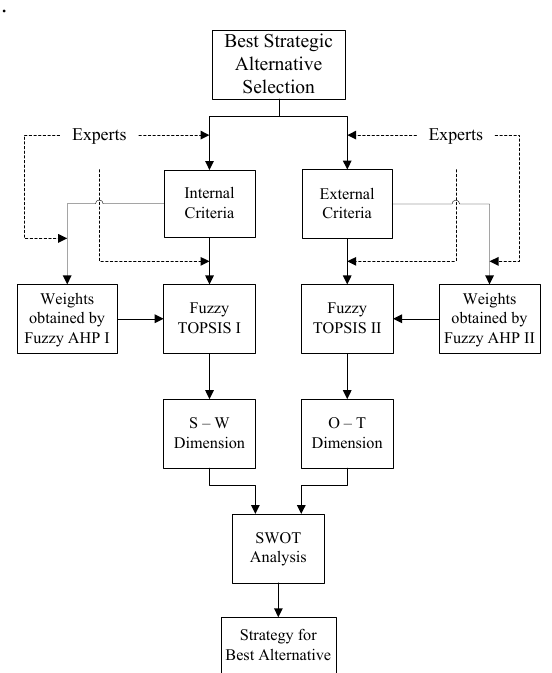
Fig. 2. Flow Chart of the Proposed Fuzzy SWOT